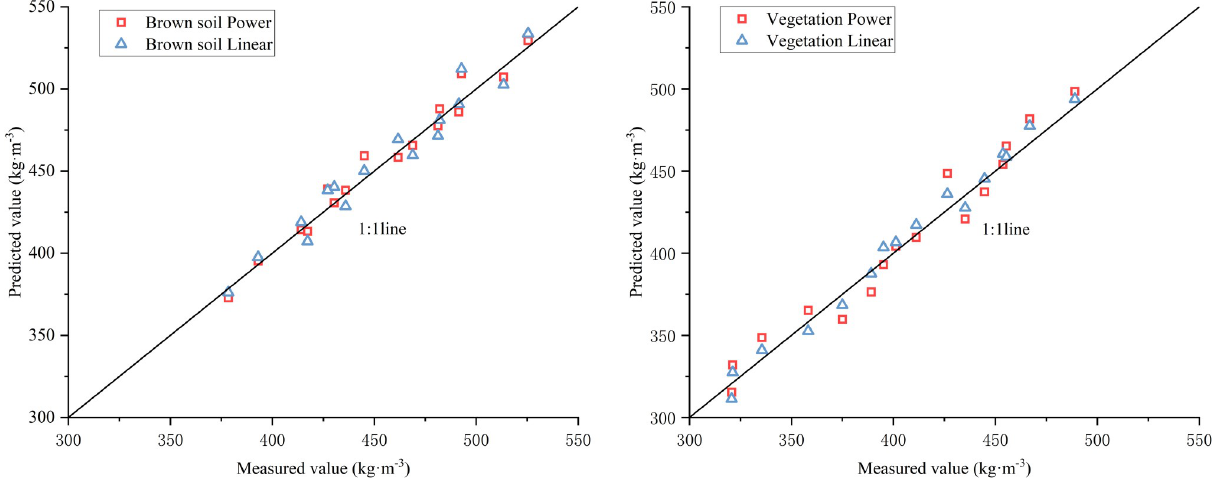
Fig 4. Predicted (using Table 6) and measured of T